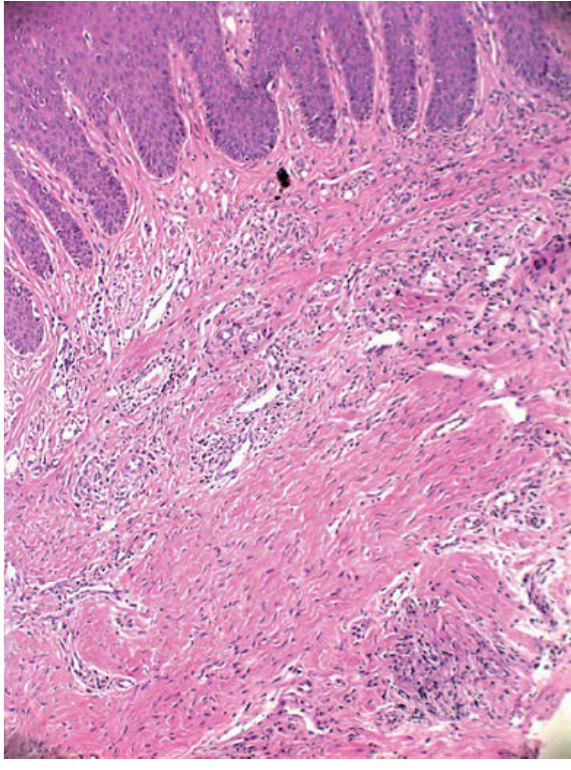
Figure 2. Photomicrographs of gingival specimens showing a small number of the focal mononuclear cell infiltrate under the superficial epithelium, especially around vascular structures. Although the inflammation is minimal, it is noteworthy that the microvascular proliferation in these areas is moderate. (Hematoxylin and eosin x200) (S-CP